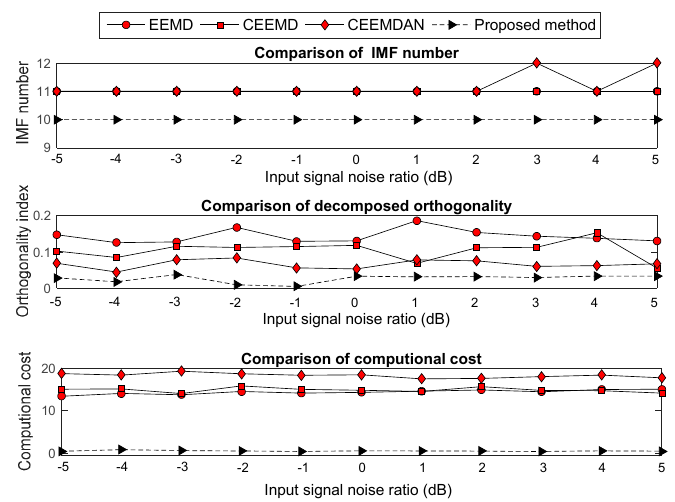
Figure 8. Comparison of the decomposition effect for the ‘bumps’ signal.